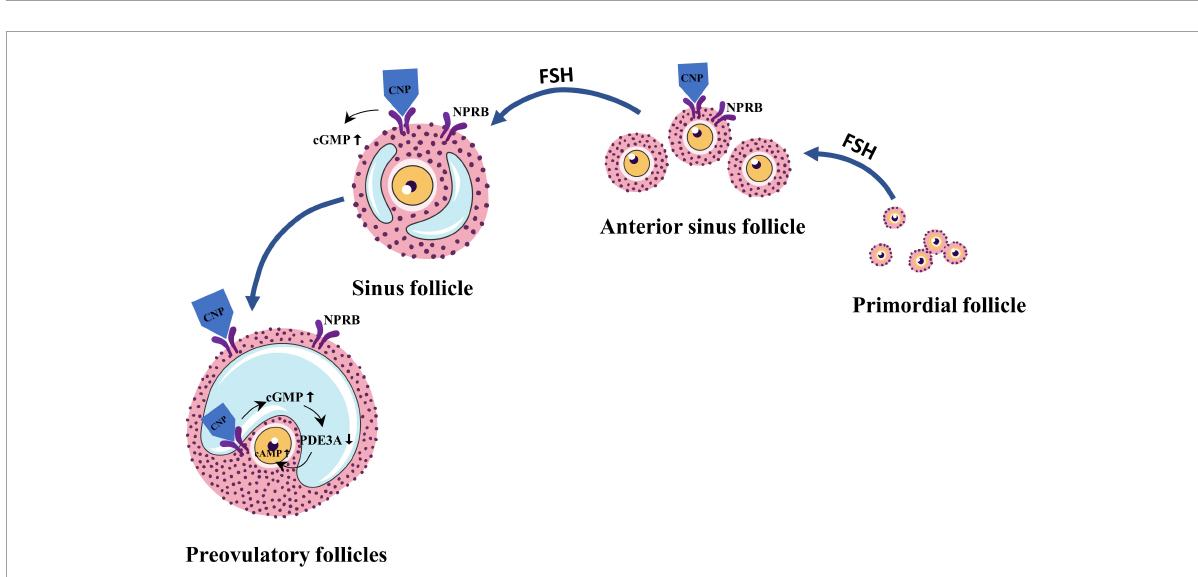
FIGURE2 C-type natriuretic peptide (CNP) is an important follicle growth regulator secreted by granulosa cells in secondary and sinus follicles in response to follicle-stimulating hormone (FSH) stimulation. Cyclic guanosine monophosphate (cGMP) and cyclic phosphate (cAMP) levels are regulated by CNP in combination with natriuretic peptide receptor-B (NPRB), thereby regulating follicle development and maturation.